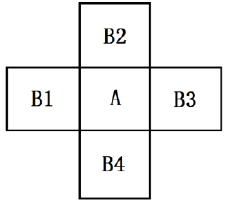
Figure 1 Four neighborhood direction diagram Traverses the four neighbourhoods direction of the current image block, if the image block of the current traversal